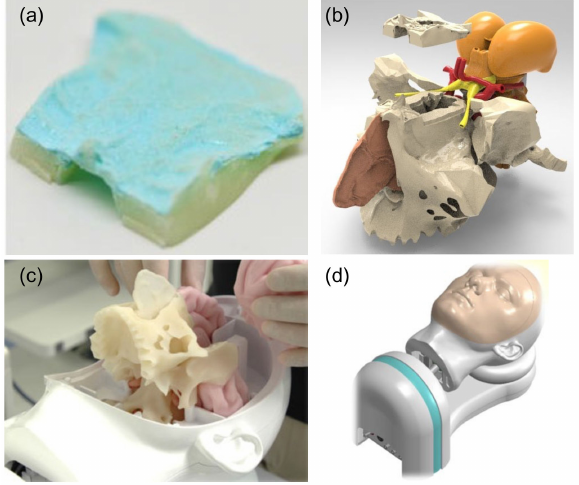
Dura-mater model was integrated into the Bionic Brain: ( a ) Dura-mater model; ( b ) nasal-septum model; ( c ) Model after integration of each model to Bionic Brain; ( d ) Bionic Brain for transnasal surgical simulator after covering the face model.